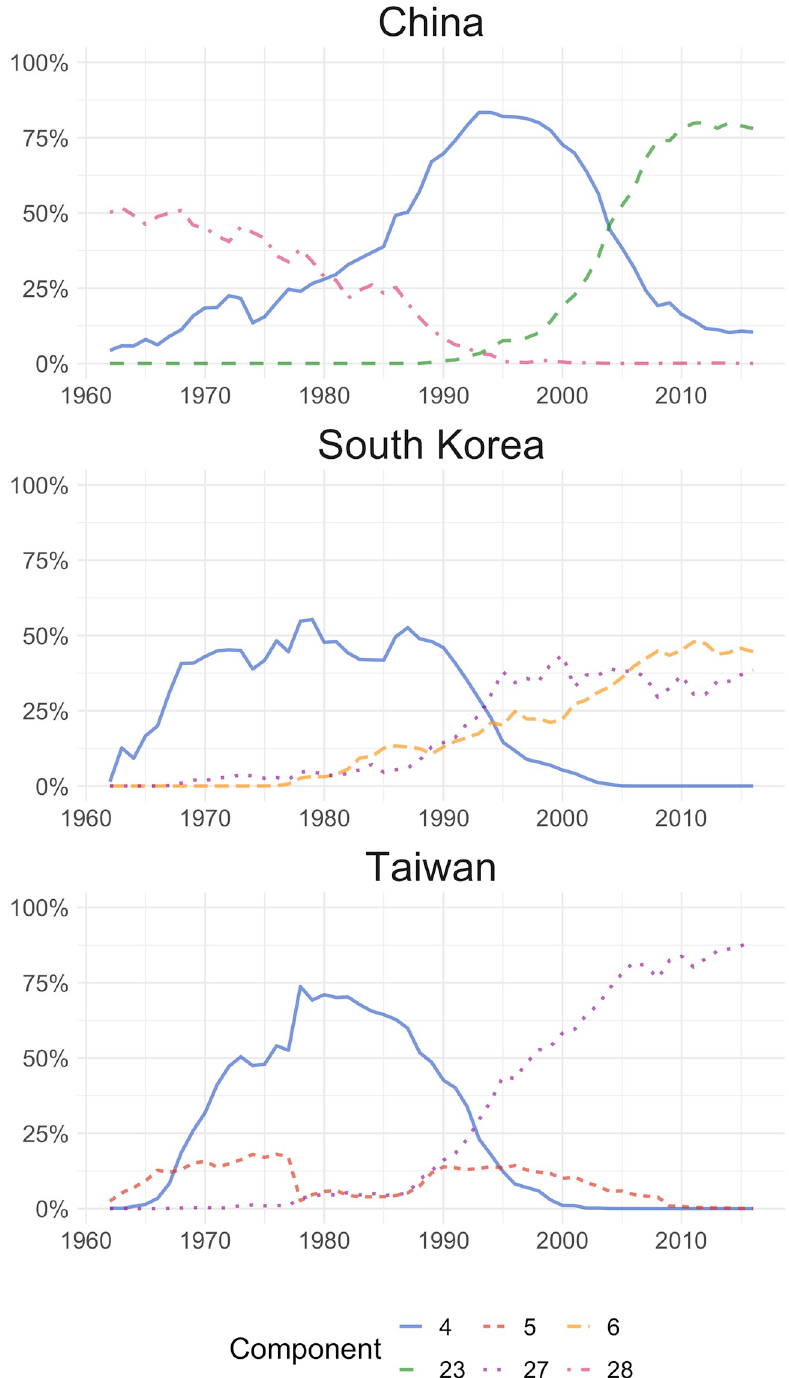
Fig 1. LDA outputs for China, South Korea and Taiwan. Distribution of the top three components by country. 4: Footwear, clothing and toys; 5: Non-digital electronics; 6: Vehicles, boats, machinery and parts; 23: Processors, microcircuits, toys and shoes; 27: Electronic microcircuits and machinery parts. 28: Rice, cotton, textiles.